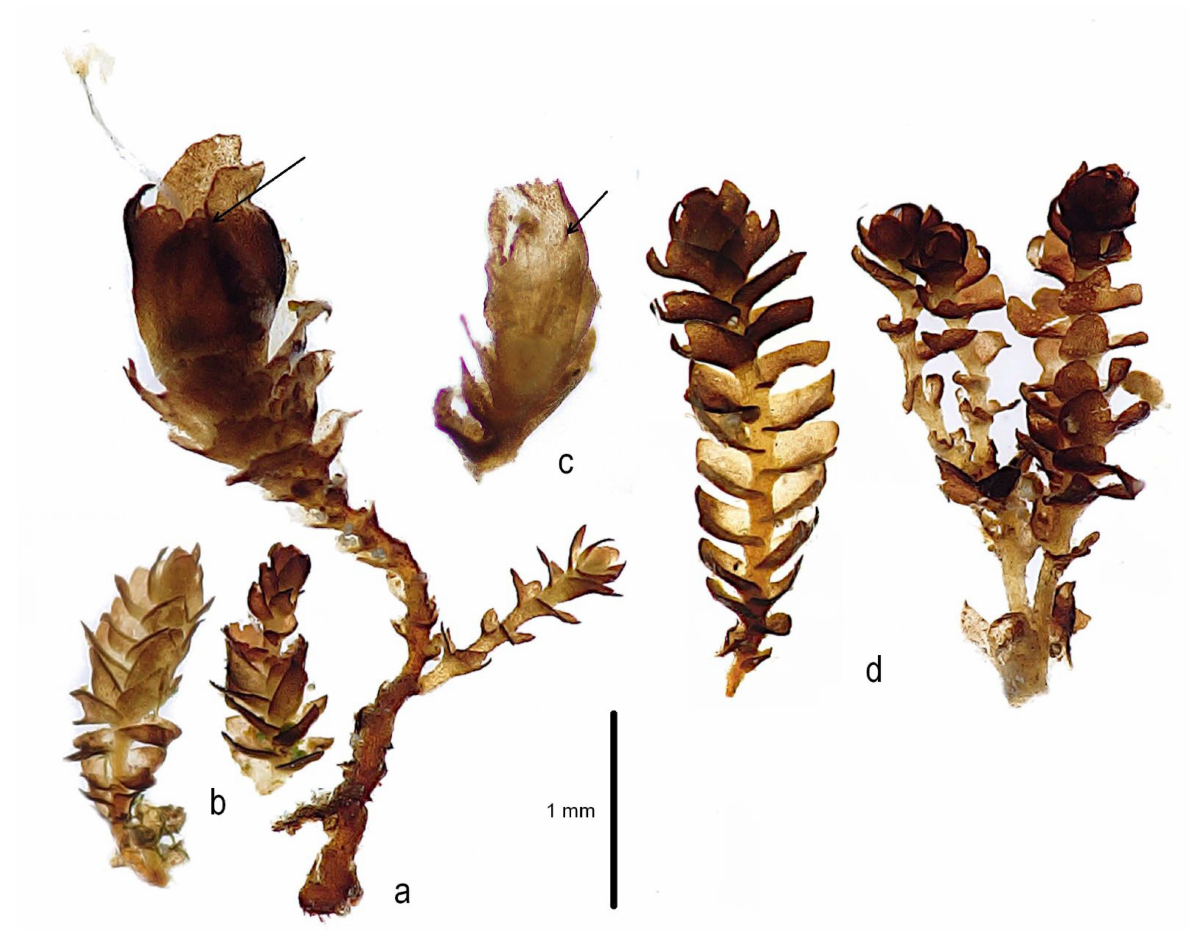
Figure 3. Marsupella lusitanica R.D. Porley & Jan Kuˇcera, habit microphotographs: ( a ) female plant with perianth (arrow) and sporophyte; ( b ) two male shoots; ( c ) section of gynoecium showing the perigynium, enlarged bracts, and a smaller perianth (arrow) inside; ( d ) two sterile shoots. ( a , c )